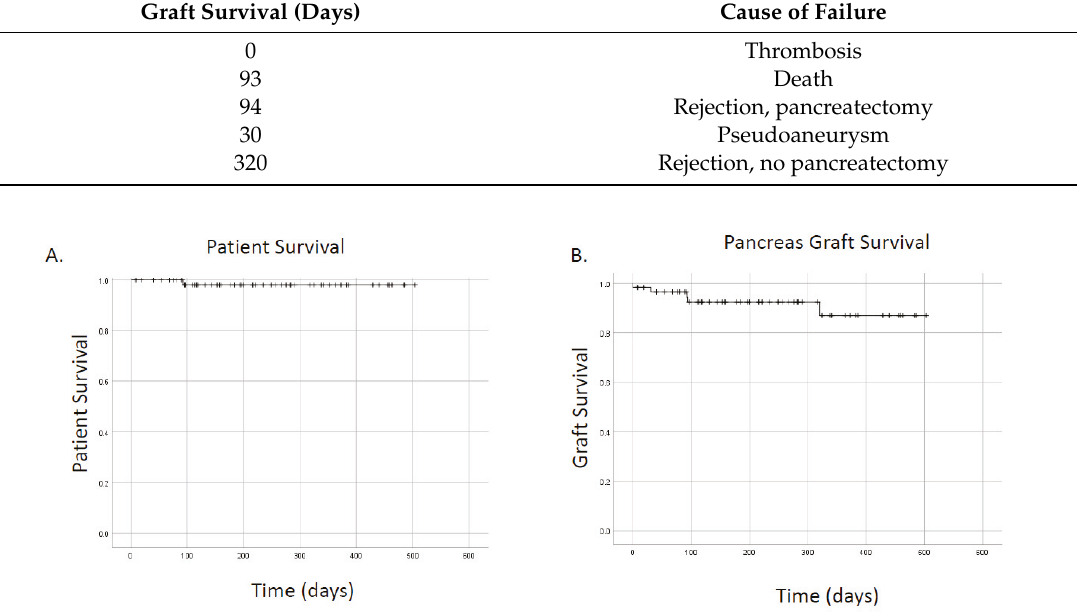
Figure 1. Patient and graft survival for recipients of pancreas transplants. ( A ) patient survival. ( B ) graft survival.